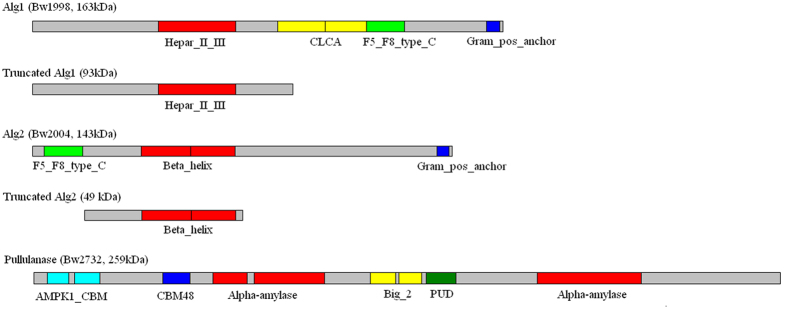
Domain architectures of the high-molecular-weight enzymes in B. weihaiensis Alg07.Hepar_II_III, heparinase II/III-like protein; CLAL, calcium-activated chloride channel; F5_F8_type_C, F5/8 type C domain; Gram_pos_anchor, Gram-positive anchor; Beta_helix, right-handed beta helix region; AMPK1_CBM, glycogen recognition site of AMP-activated protein kinase; CBM48, carbohydrate-binding module 48; Alpha-amylase, α-amylase catalytic domain; Big_2, bacterial Ig-like domain (group 2); PUD, bacterial pullanase-associated domain.